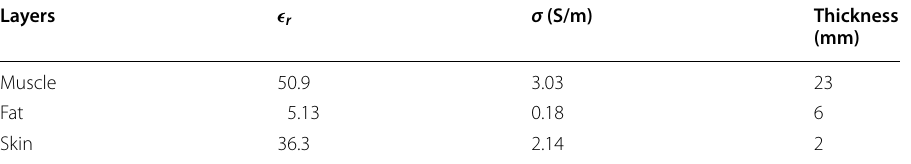
Table 3 Dielectric characteristics of human tissue at 7.4 GHz